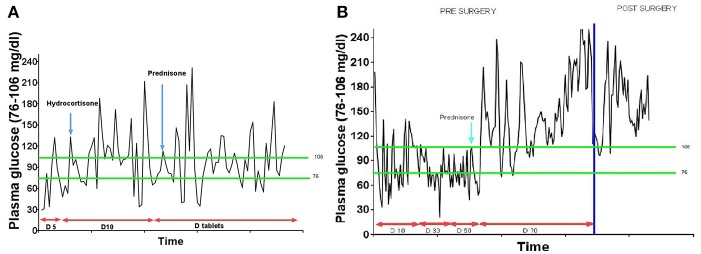
(A) Plasma glucose trend in case 1. (B) Plasma glucose trend in case 2.